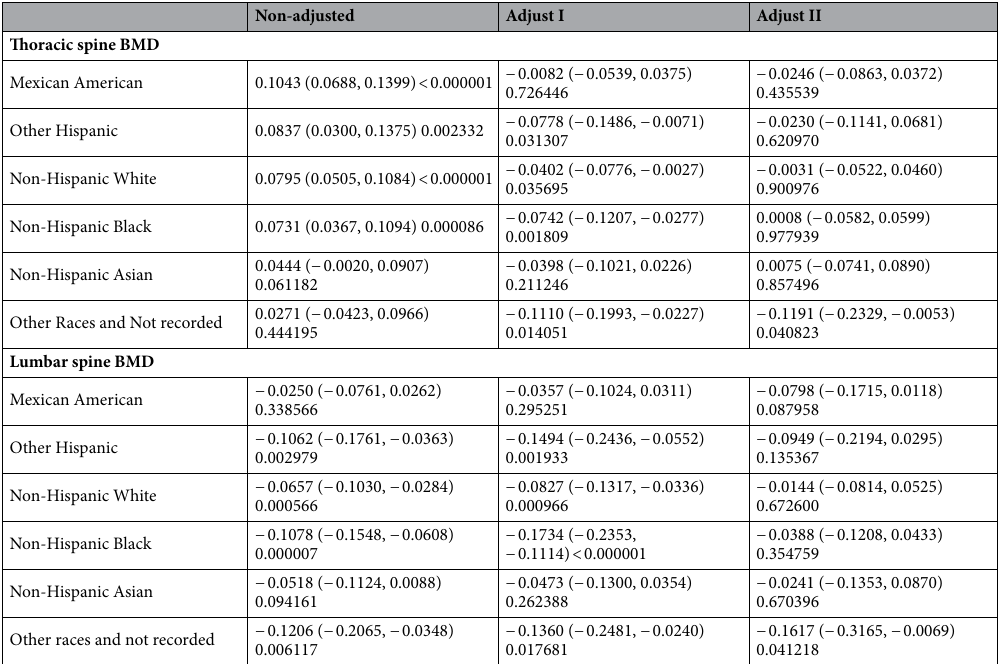
Table 4. Association between HGB and BMD stratified by race. Expose variable HGB (g/dL), ending variable lumbar spine BMD, the results in the table are expressed as β (95% CI). Model 1, no covariates were adjusted. Model 2, age, sex were adjusted. Model 3, age, sex, annual household income, education level, SBP, DBP, BMI, red blood cell count, albumin, ALP, ALT, blood urea nitrogen, total calcium, iron, CPK, creatinine, glucose, LDH, phosphorus, total bilirubin, total protein, uric acid, albumin creatinine ratio, blood cadmium, blood lead, phosphorus, potassium, triglyceride, LDL-C, HDL-C, total cholesterol, alcohol status, smoking status and diabetes were adjusted. In the subgroup analysis stratified by race, the model is not adjusted for the stratification variable